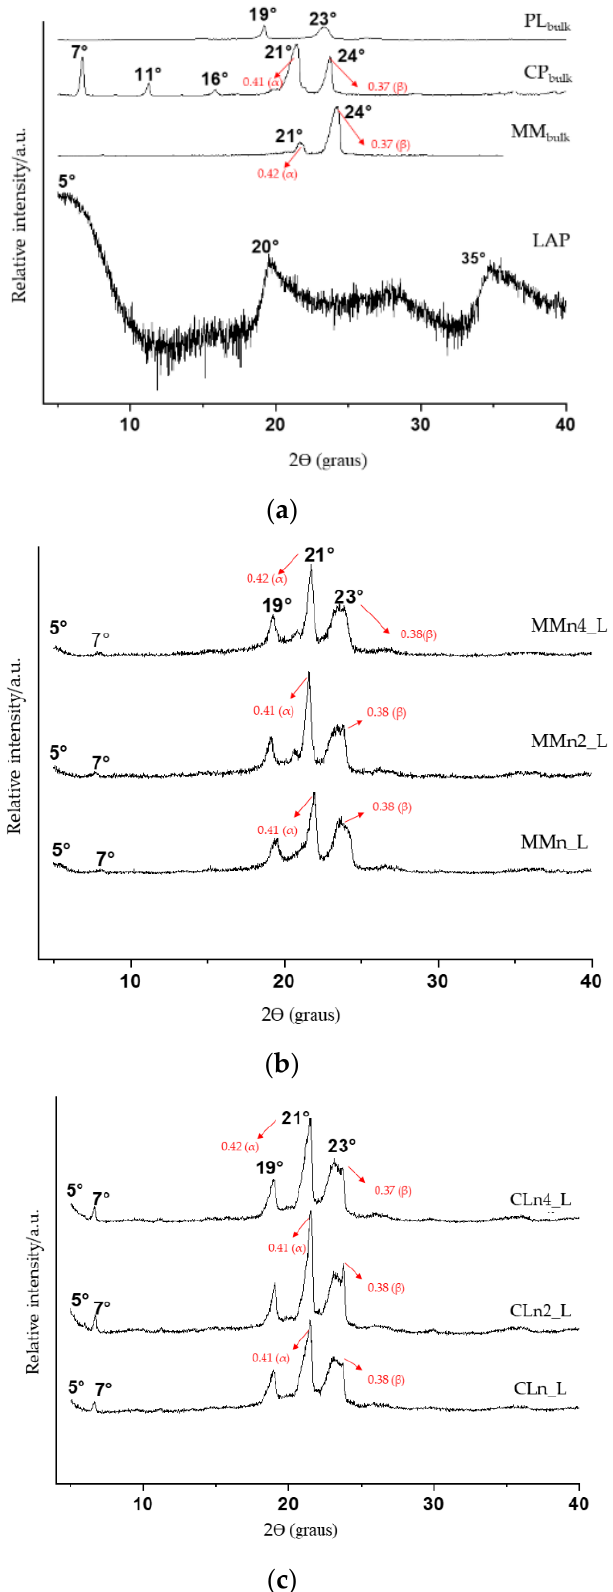
Figure 4. X-ray diffractograms (XRD) in terms of relative intensity vs. 2 θ of isolated components ( a ), hybrid nanoparticles prepared by MM ( b ), and hybrid nanoparticles prepared by CP ( c ).